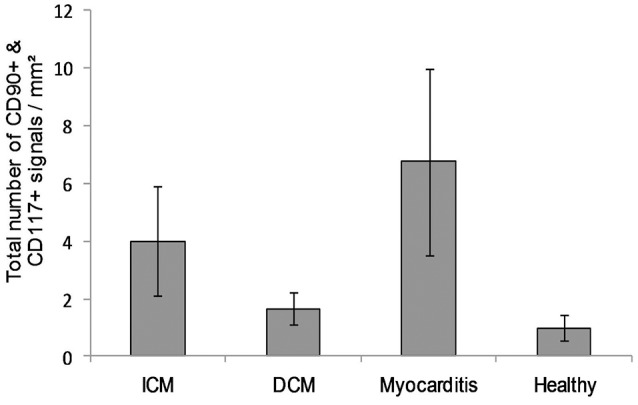
A number of cells with co-expression of CD90 and CD117 per square millimeter (n = 12). The data are expressed as mean ± standard deviation. The Myocarditis patient group displayed the most cells with co-expression of both stem cell markers.